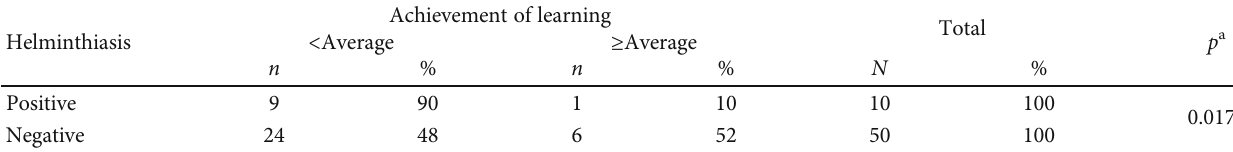
Table 5: Helminthiasis and achievement of learning.